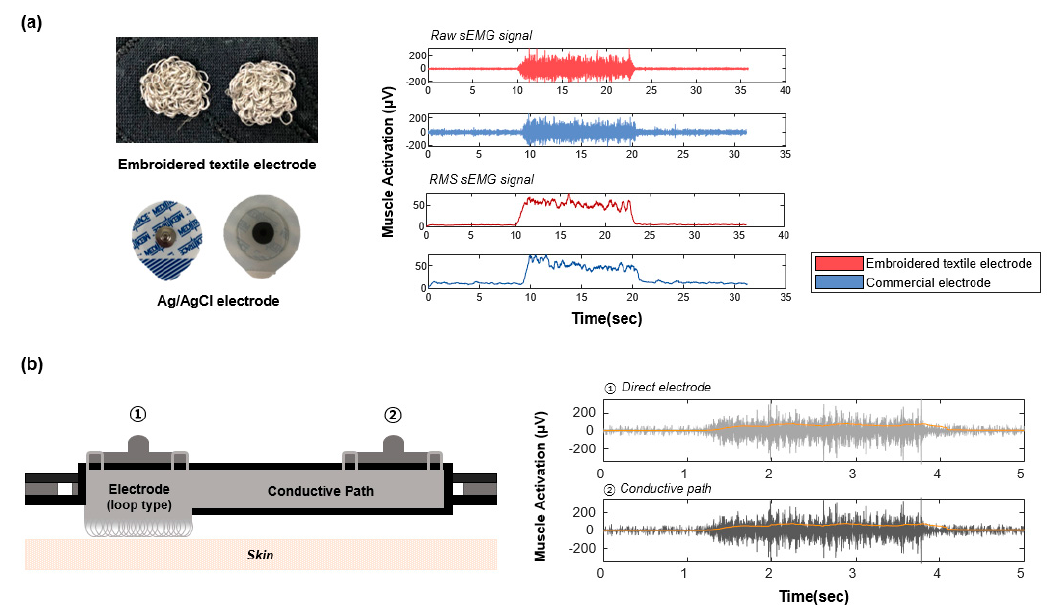
Figure 8. Representative surface electromyography (sEMG) signals. ( a ) sEMG signals obtained from the embroidered textile electrode and the commercial electrode, respectively; ( b ) sEMG signal of the embroidered textile electrode via the direct electrode and conductive path.